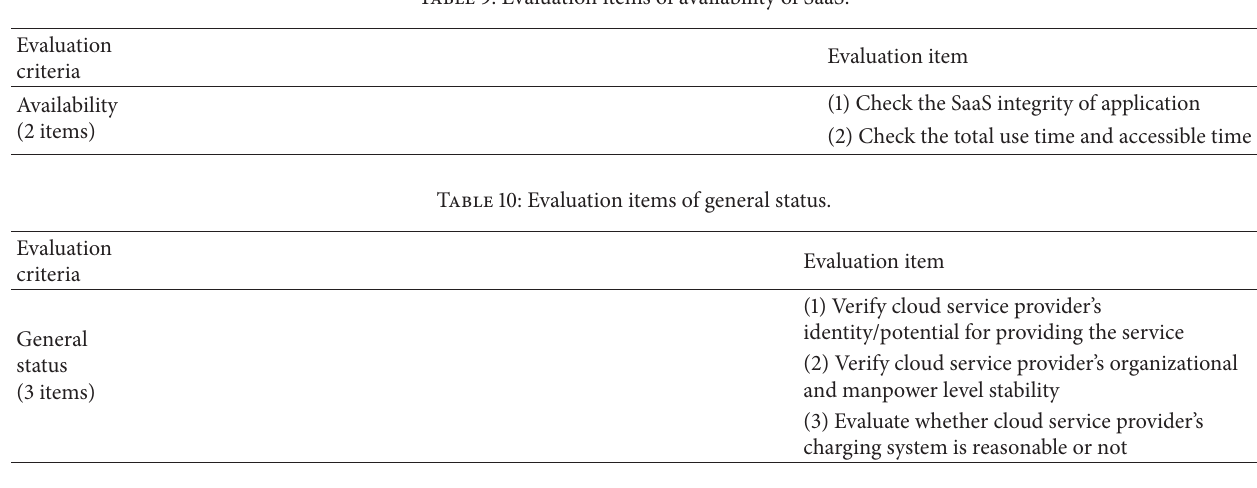
Table 11: Evaluation items of network and data center—service provision basis.